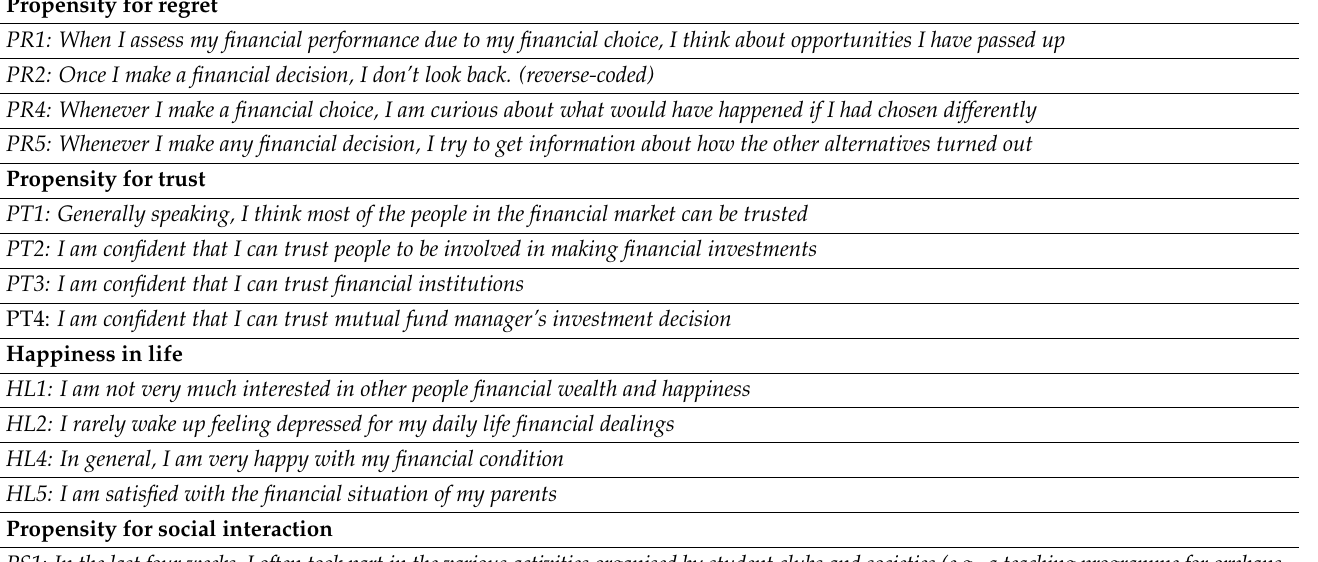
Table A2. Constructs, items, and code